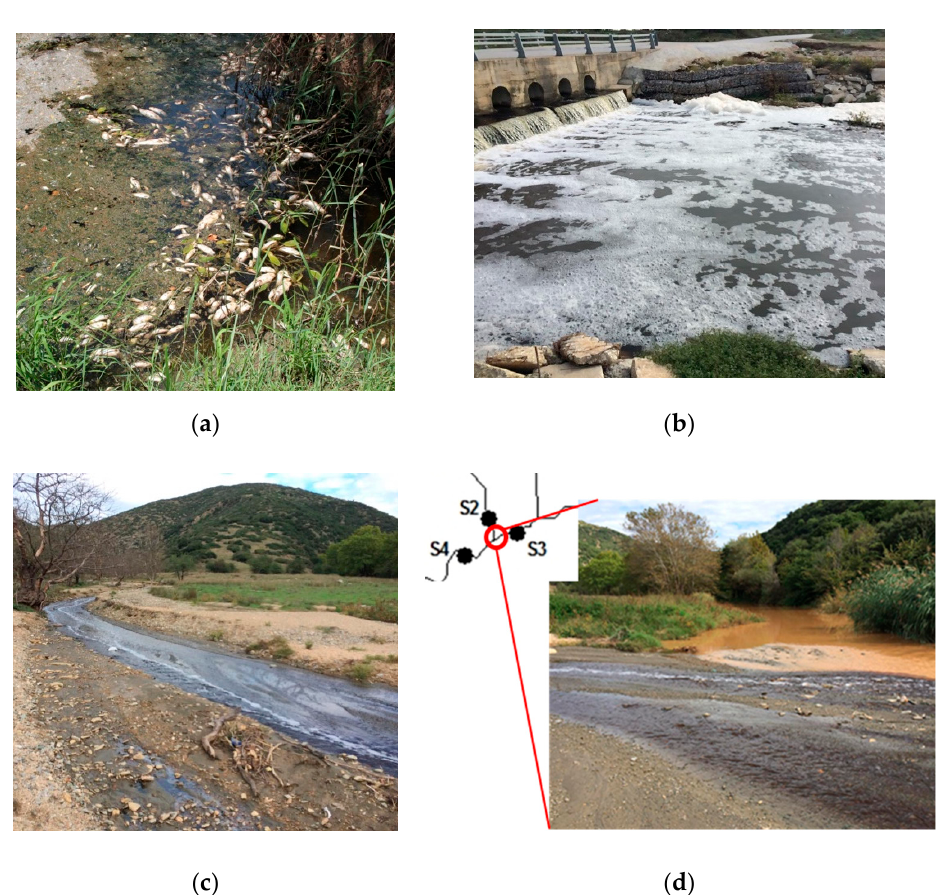
Figure 2. ( a ) Dead fish observed, June 2015, ( b ) foam in S7, ( c ) black colored water at site S2, ( d ) the confluence of stream branches above S4, October 2015, Bogdanas River.